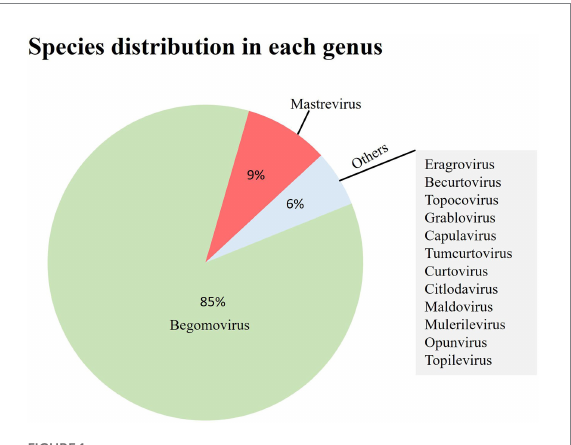
FIGURE 1 Species distribution of geminivirus. Number of species in each genus. It can be clearly seen that the genus Begomovirus has the highest number of species among the family